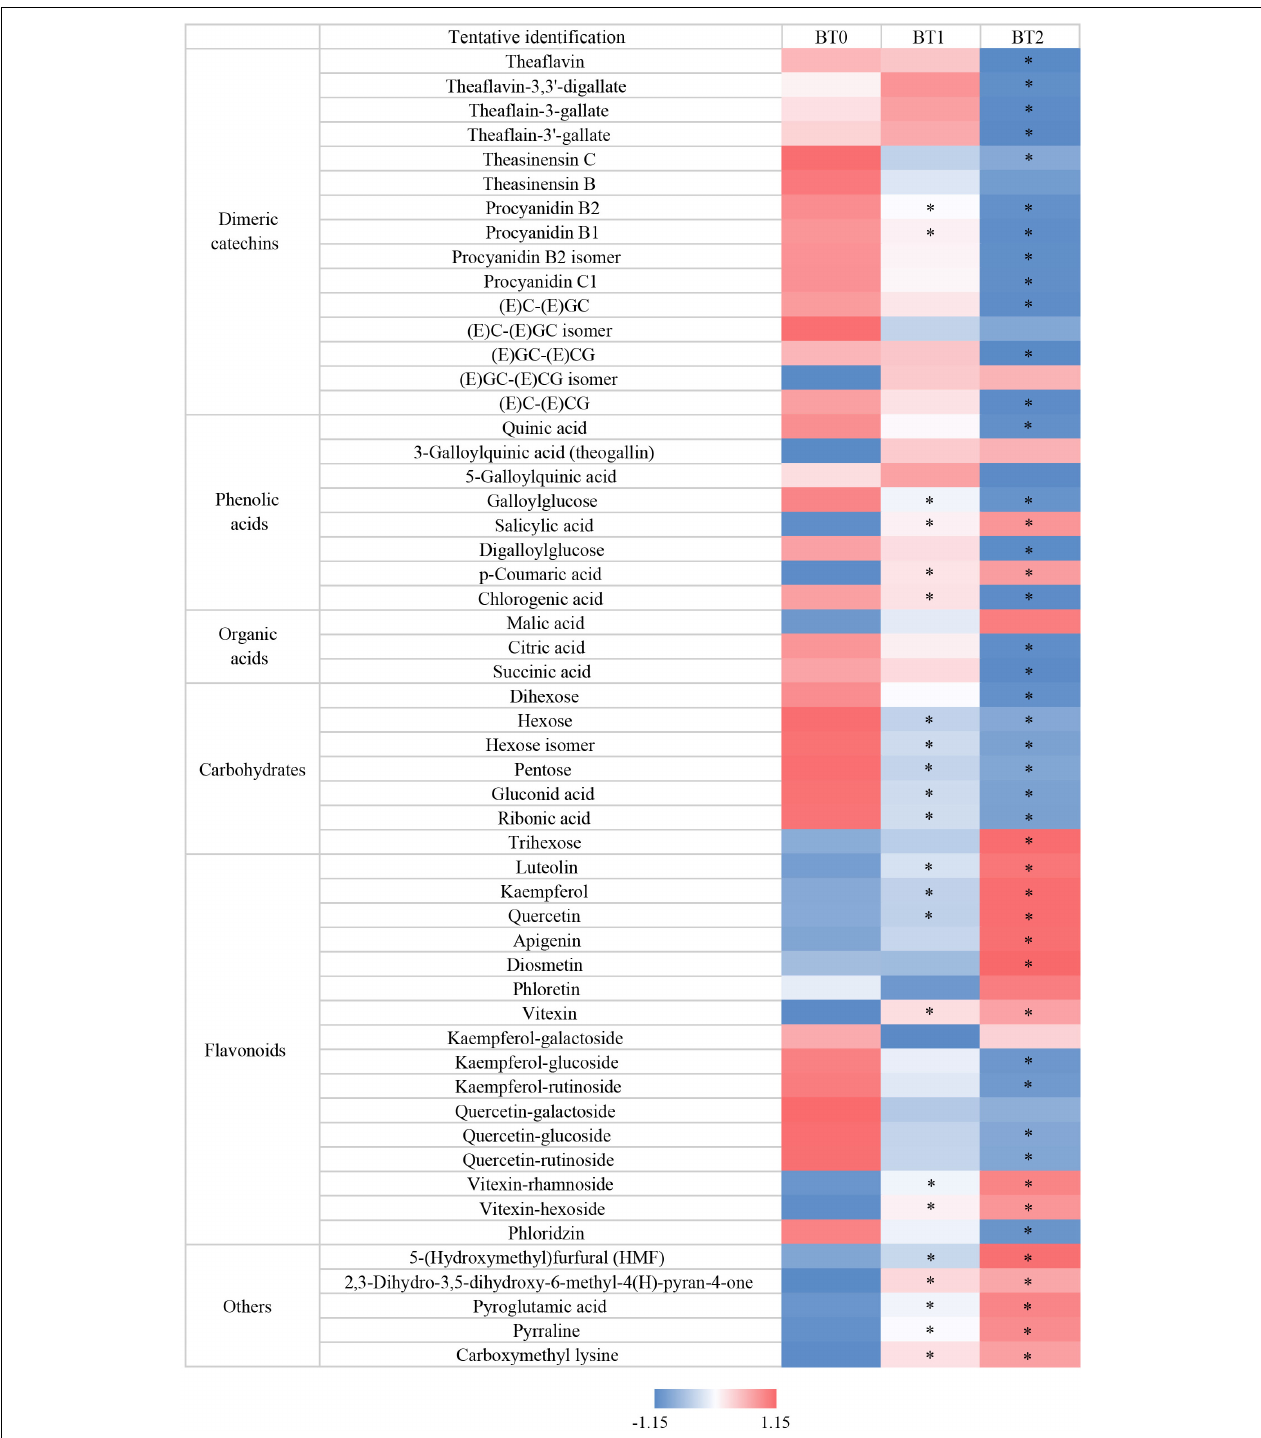
FIGURE 2 | Heatmap of Z -score normalized relative abundances of non-volatiles identified by UPLC-QE-Orbitrap-MS. * P < 0.05 indicates significant difference.